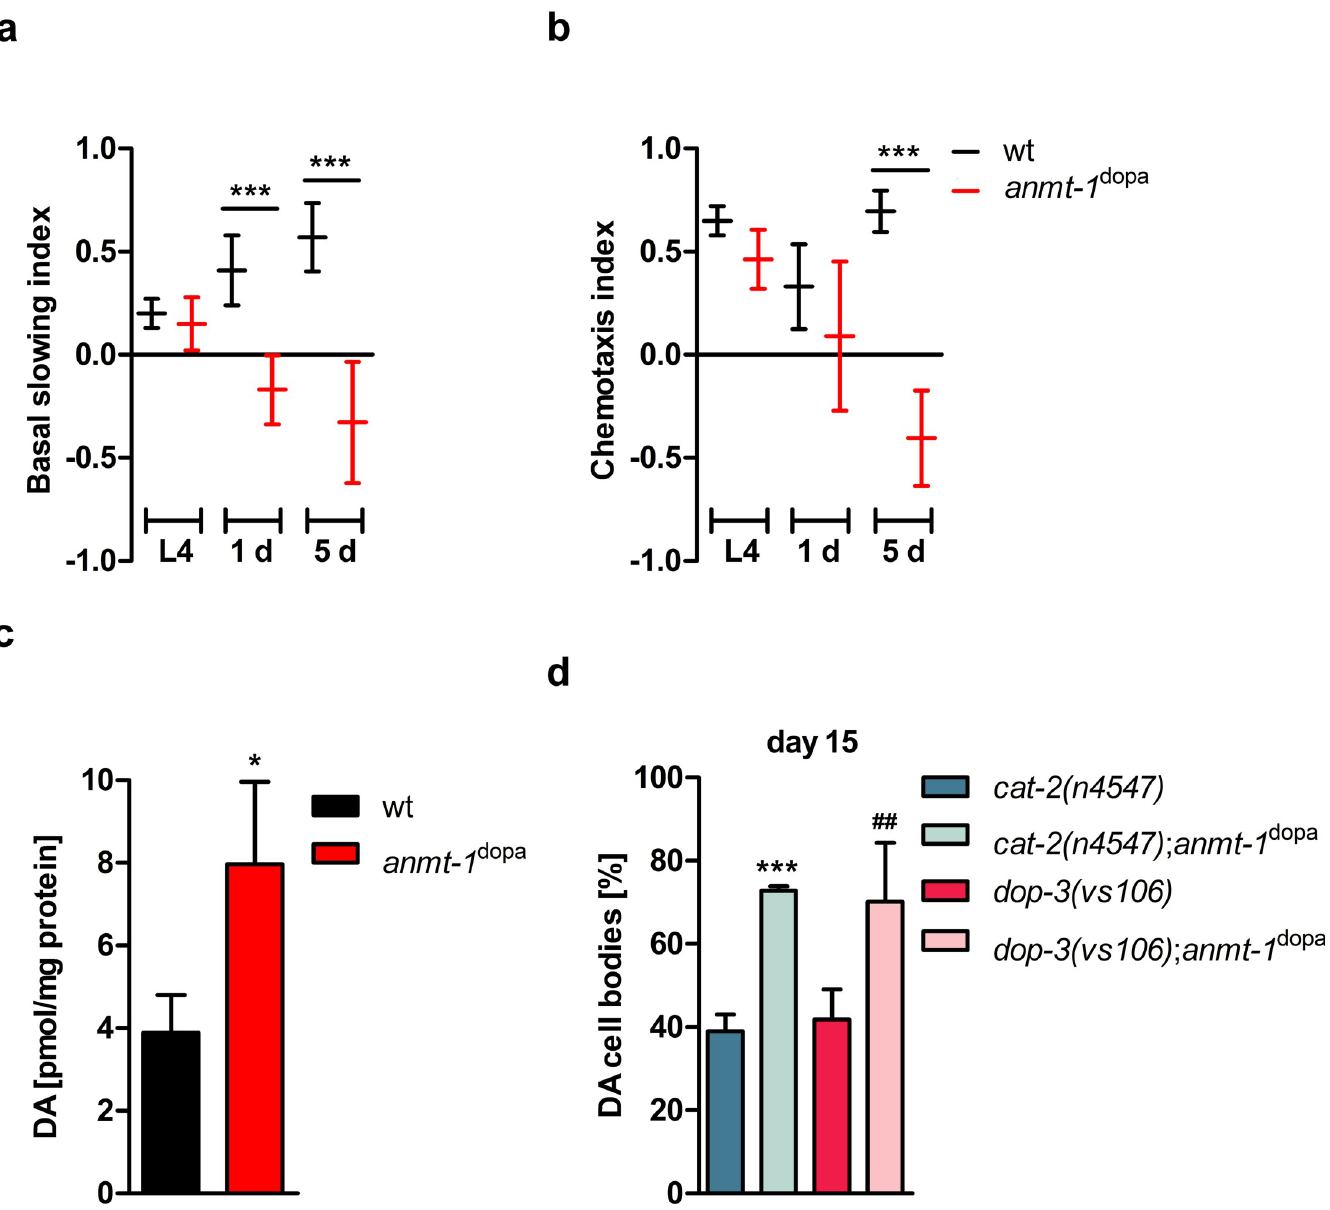
Fig 2. anmt-1 dopa expression affects behavior and dopamine levels, but influences neurodegeneration and lifespan independently of dopamine signaling.a and b Dopamine-dependent behaviors in wt (black) and anmt-1 dopa (red) at L4, L4 + 1 day, and L4 + 5 days of adulthood. a Basal slowing index. b Chemotaxis index based on ethanol avoidance behavior. c Dopamine concentration in pmol/mg protein of a mixed population of wt and anmt-1 dopa . d Presence of (DA) cell bodies in cat-2(n4547); anmt-1 dopa (light turquoise) compared to cat-2(n4547) (turquoise), and dop-3(vs106) ; anmt-1 dopa (light pink) compared to dop-3(vs106) (pink) at day 15 of adulthood. � : p < 0.05, ## : p < 0.05, ��� : p < 0.001, d � compared to cat-2(n4547) , # compared to dop-3(vs106)